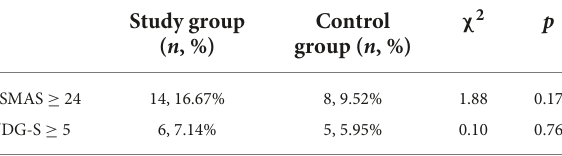
TABLE 3 The prevalence of addictive behaviors between the two groups: Based on BSMAS and VDG-S scores. Study group ( n , %)